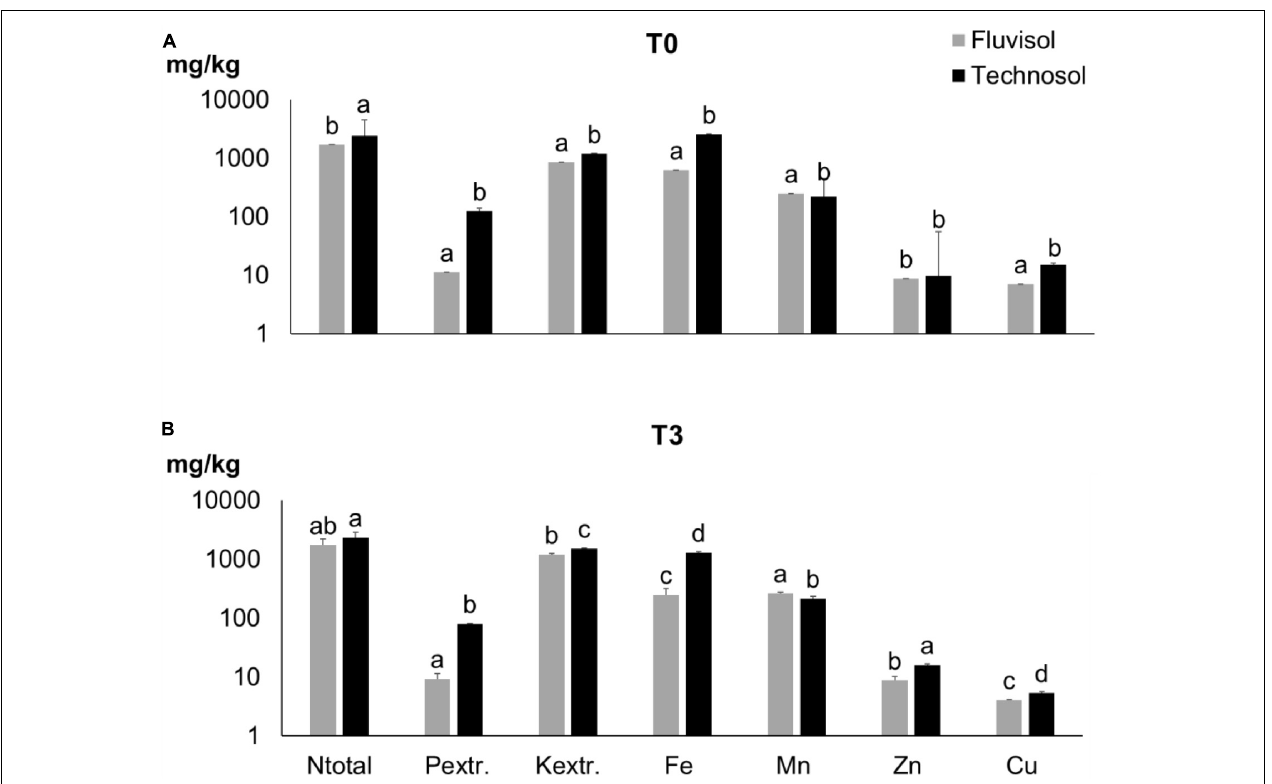
FIGURE 2 | Nutrients concentration in Fluvisol and in Technosol (means ± SD; n = 5) in the beginning (T0) (A) and at the end (T3) of assay (B) . Different letters for the same element indicate significant differences between time and substrata ( p < 0.001, two-way ANOVA (time x substrata) followed by Tukey HSD test).